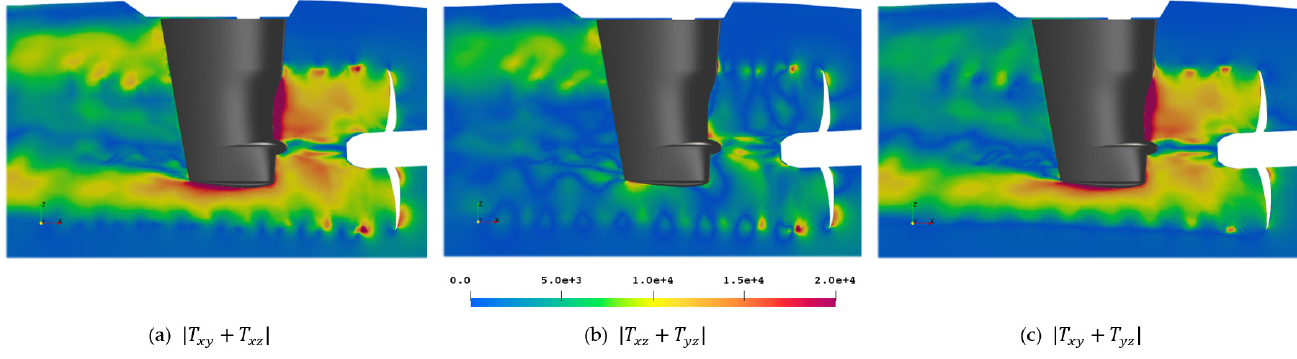
Figure 24. Lighthill stress tensor T ij magnitude of off-diagonal components in [ Kg/ms 2